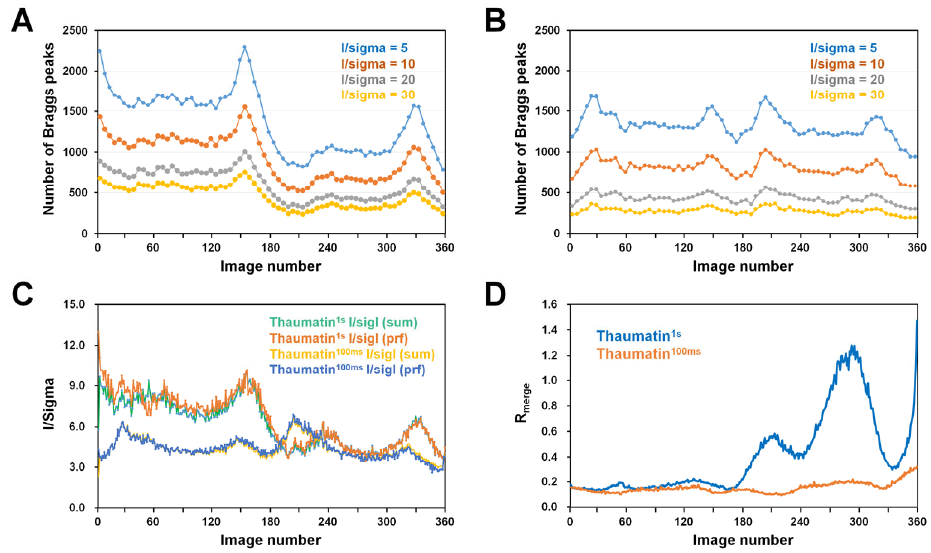
Figure 3. Analysis of the diffraction images of Thaumatin 1s and Thaumatin 100ms . Number of Bragg peaks as a function of I/sigma value for ( A ) Thaumatin 1s and ( B ) Thaumatin 100ms . ( C ) I/sigI with summation and profile fitting for Thaumatin 1s and Thaumatin 100ms . ( D ) R merge values of Thaumatin 1s and Thaumatin 100ms